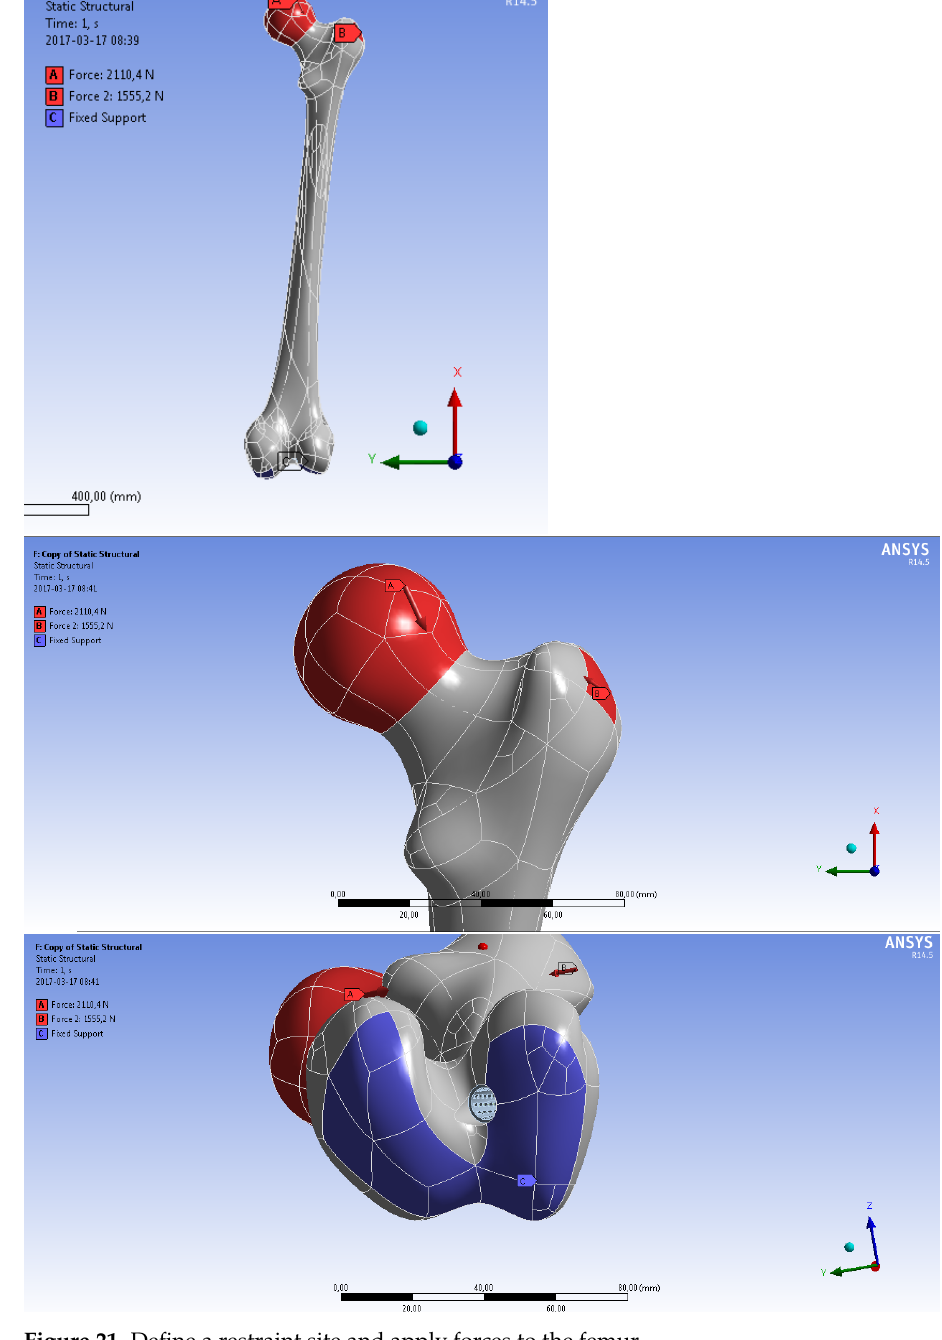
Figure 21. Define a restraint site and apply forces to the femur.